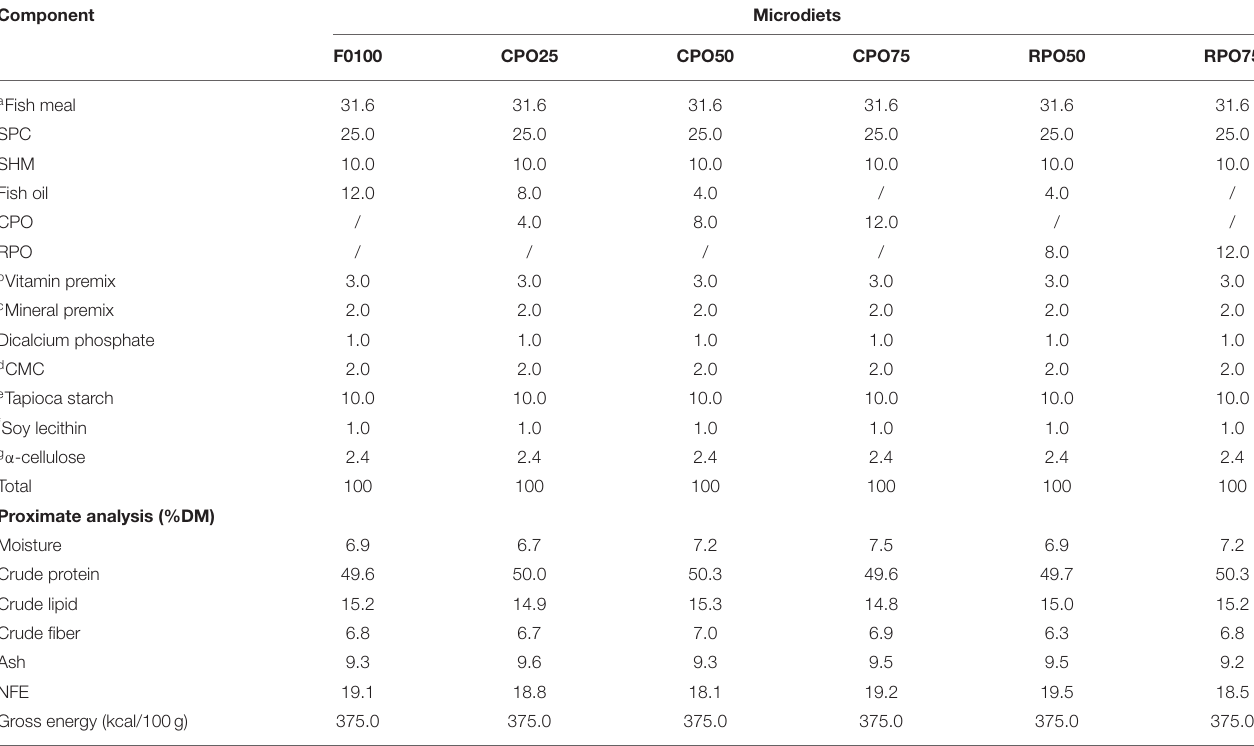
TABLE 1 | Dietary and proximate composition of different microdiets (g/100g).